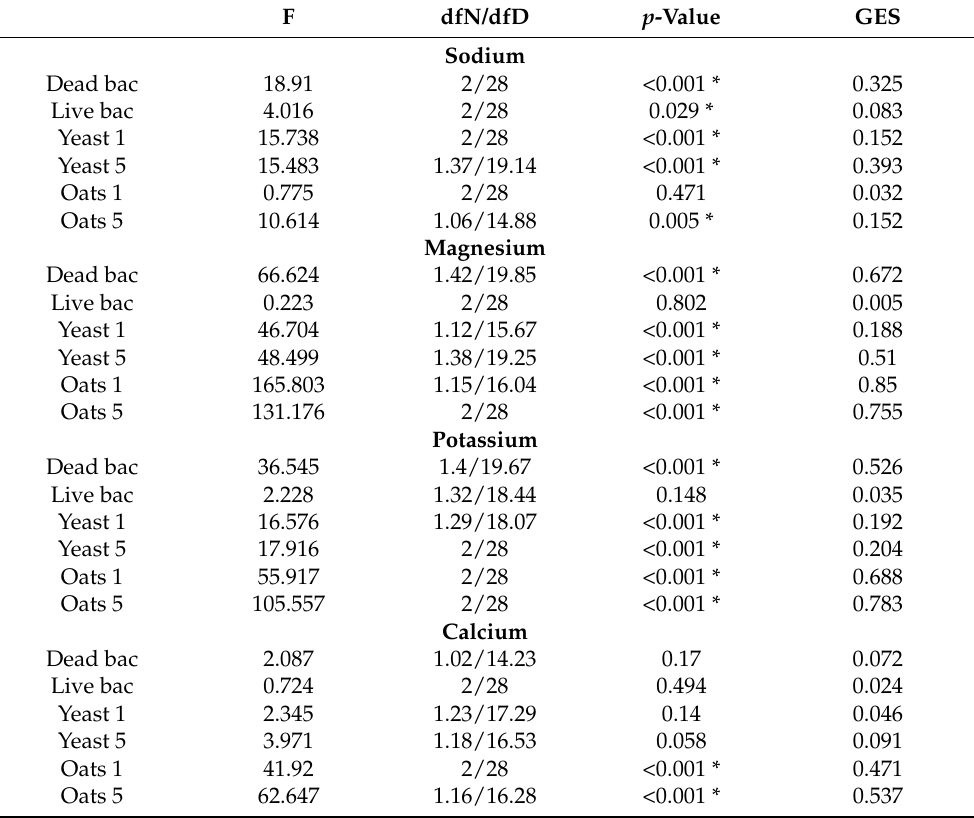
Table 3. Repeated measures ANOVA